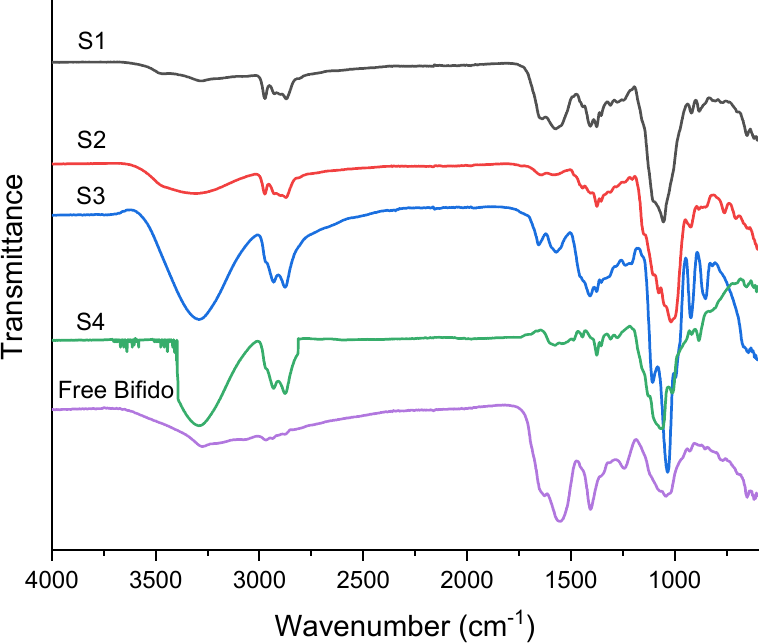
Figure 5. FTIR spectra of Bifido cells encapsulated within electrosprayed ETC core-shell microcap- sules, and non-encapsulated (free) Bifido.